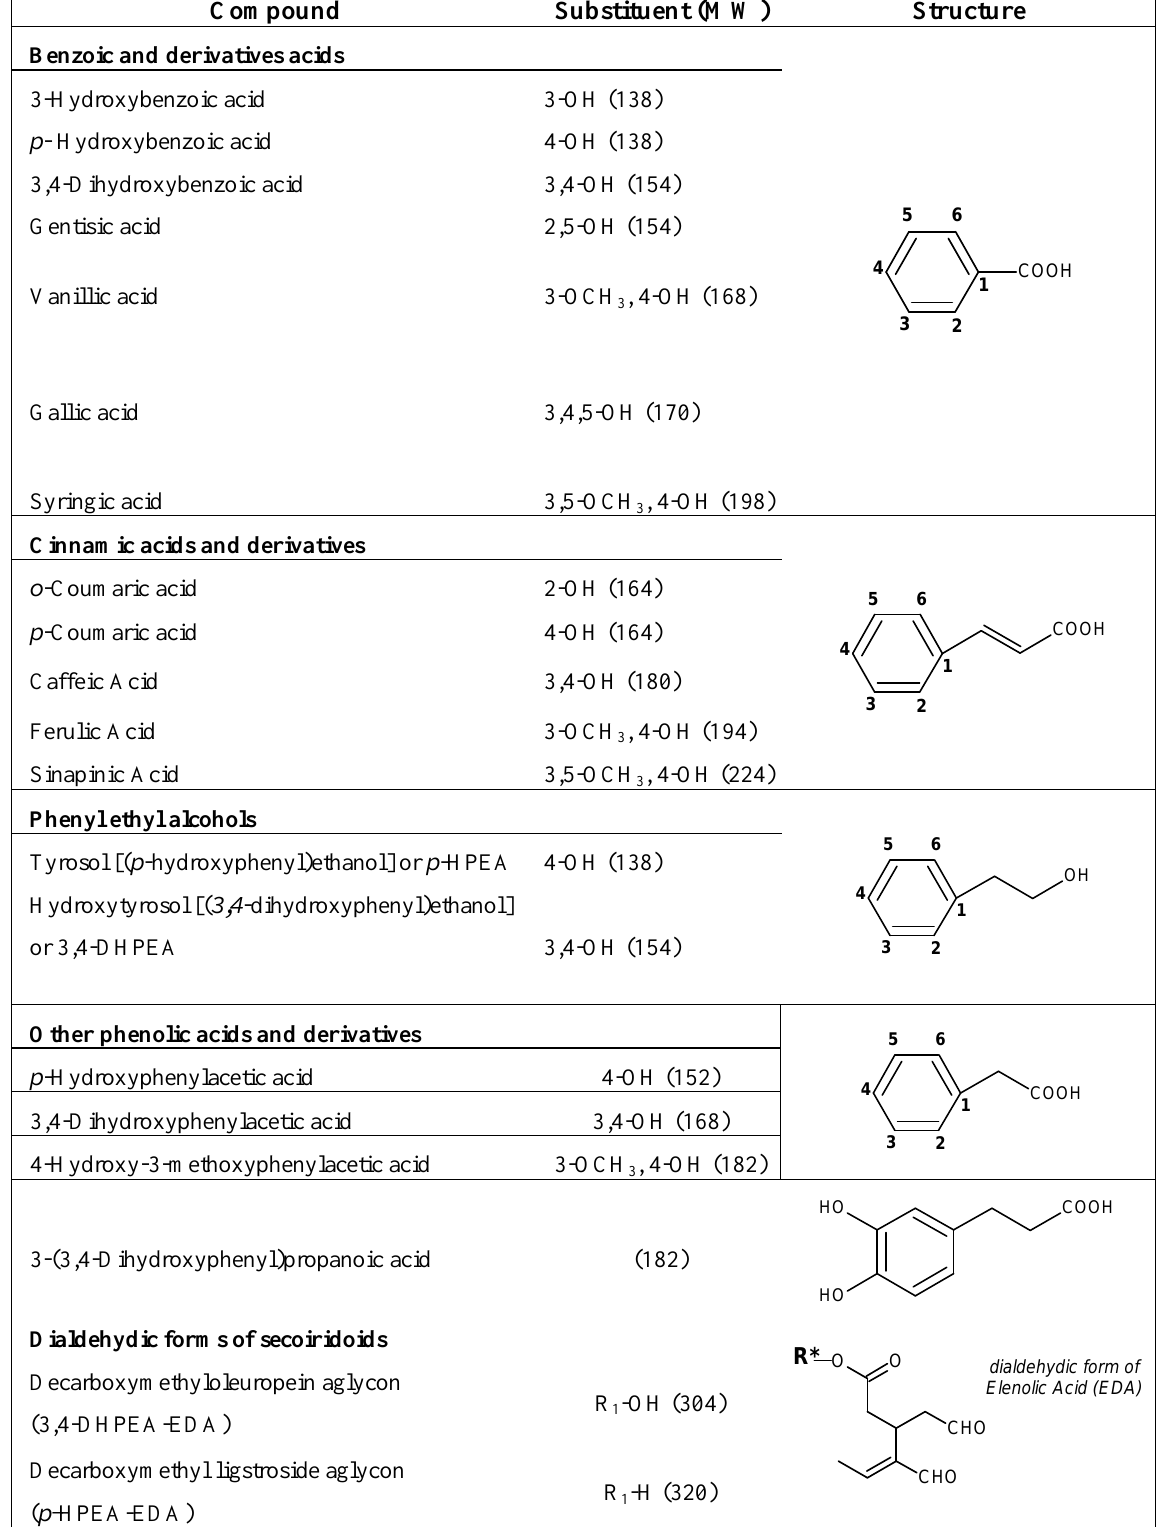
Table 1. Phenolic compounds in virgin olive oil: compounds name, general chemical structure and molecular